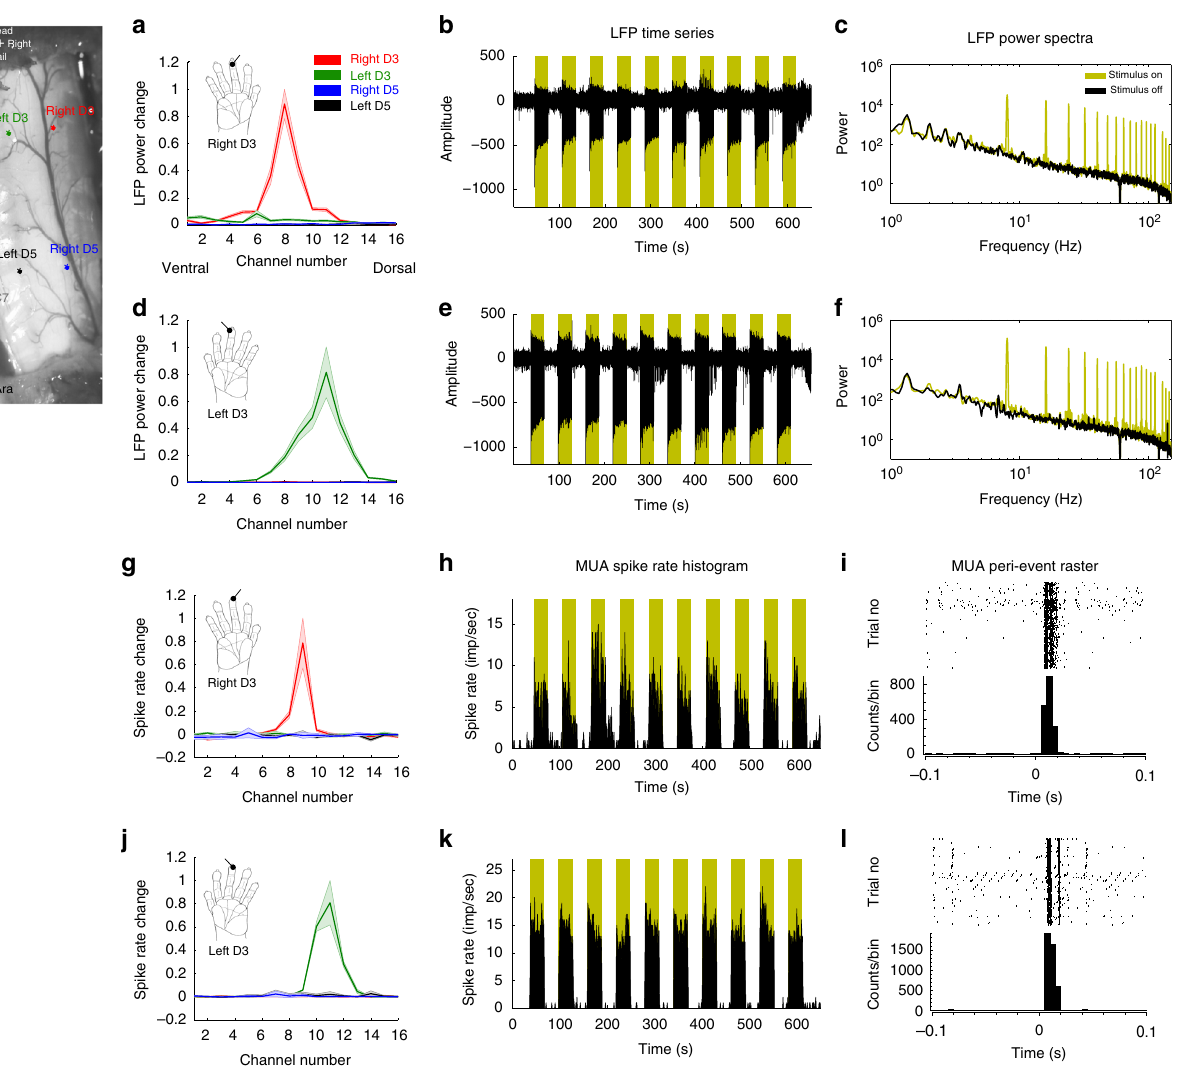
Fig. 2 Stimulus-driven LFP and spike activity responses in one representative monkey, SM-Ara. a , d Normalized averaged ( n = 3 runs) LFP power changes computed from Welch ’ s power spectra, and ( g , j ) normalized spike rate ( n = 3 runs) changes between 30 s stimulus-on and -off in all four electrodes under right-D3 and left-D3 innocuous 8-Hz tactile stimulus conditions, respectively. Shaded error bars represent standard error of mean. b , e LFP time series from the channel that presents the greatest power change and its respective ( c , f ) Welch ’ s power spectra. Dark yellow shaded regions and plots represent stimulus-on periods. h , k Spike rate histograms at the channels corresponding to the largest changes and their corresponding ( i , l ) raster plots (top row) and peri-event histograms (bottom row). Spike activity was processed for only two of the four monkeys (SM-Ara and